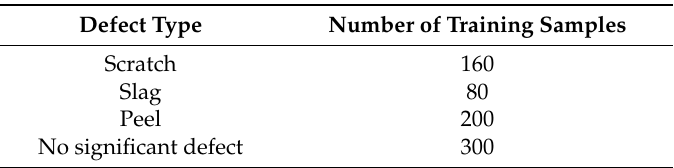
Table 7. The number of training samples for each defect type.